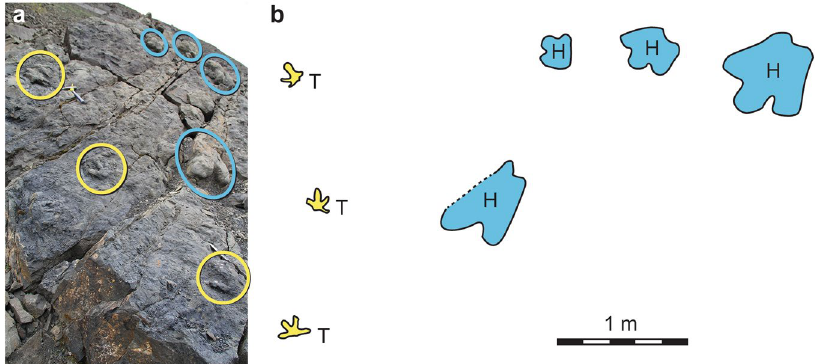
Figure 2. ( a ) Photo of large block in study area that demonstrates the co-occurrence of both hadrosaurid (in blue) and therizinosaurid (in yellow) tracks on the same bedding plane. ( b ) Line drawing of tracks on the slab in ( a ), with hadrosaurid tracks in blue, therizinosaurid tracks in yellow. Note the different sizes of hadrosaur tracks indicating multiple generations of this type of dinosaur. The oblique angle of Fig. 2 is due to the steep pitch